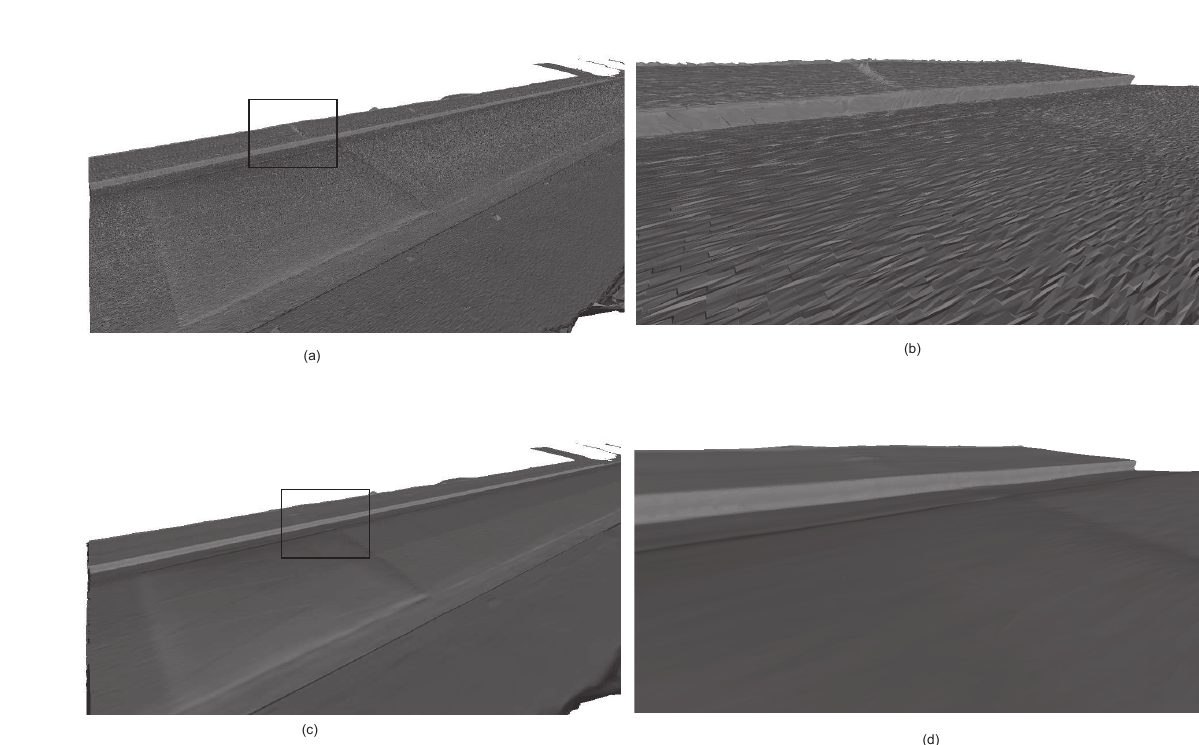
Figure 3: Mesh smoothing results on dataset Urban ♯ 2 . (a) Delaunay triangulation; (b) zoom-in view on the sidewalk border corre- sponding to the black rectangle area illustrated in Figure (b); (c) the result of the Sinc windowed smoothing procedure (d) zoom-in view on the sidewalk border corresponding to the black rectangle area illustrated in Figure (c).